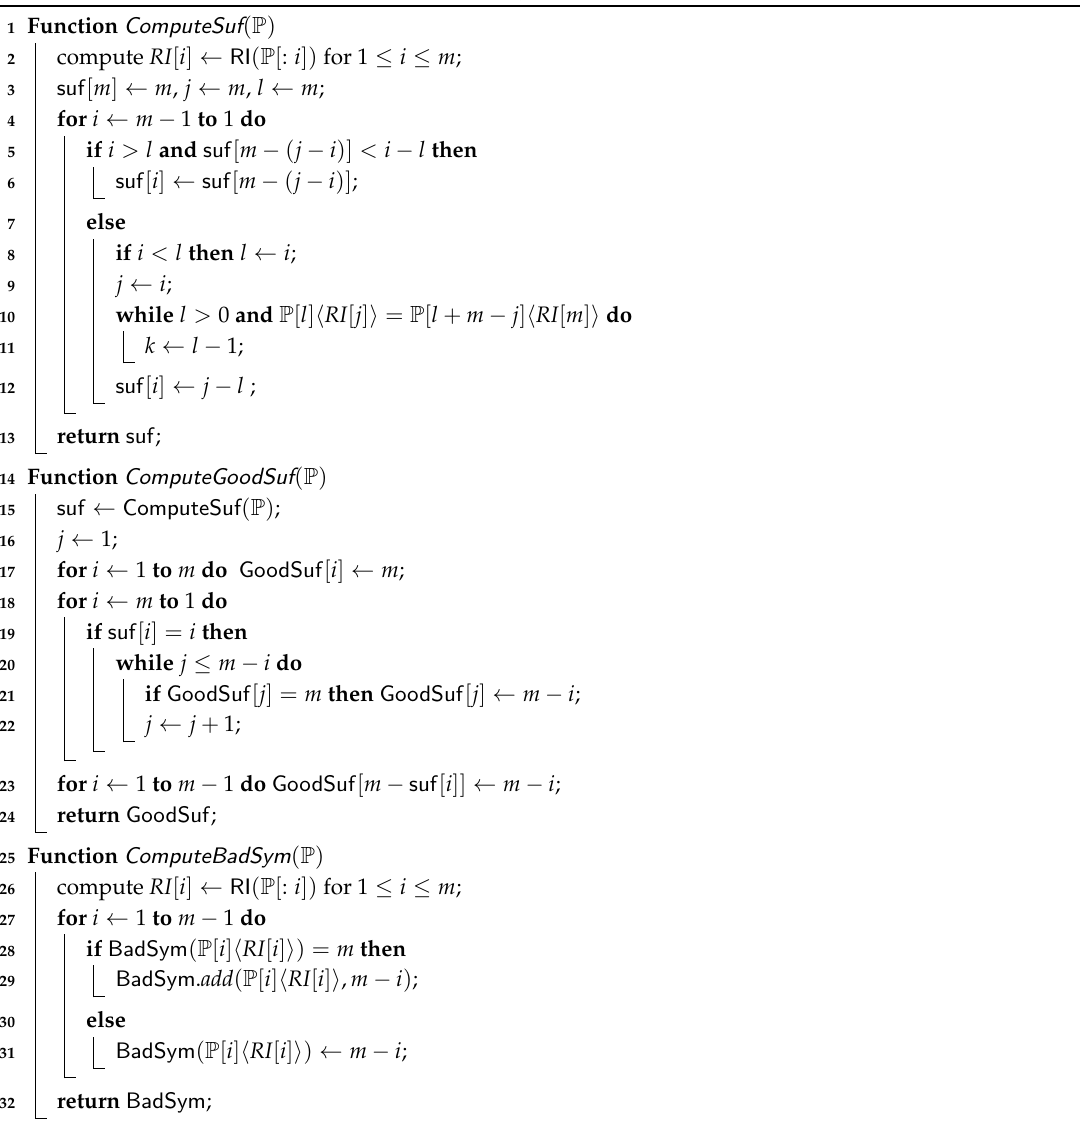
Algorithm 10: MT-BM and MT-H preprocessing